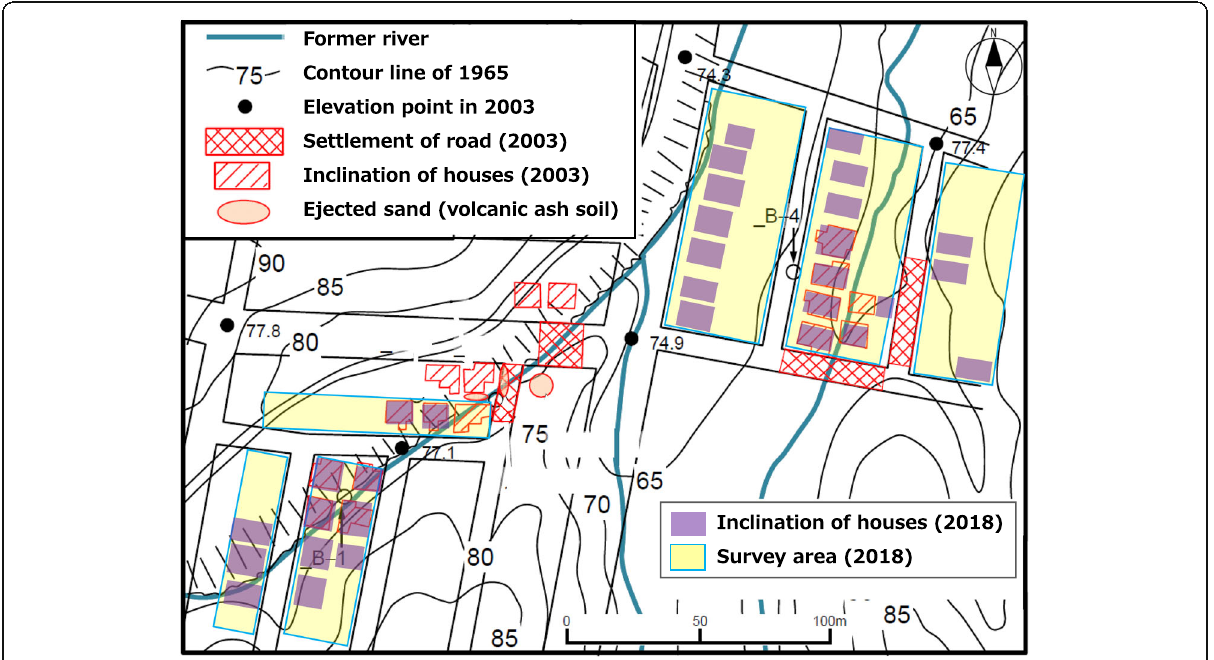
Fig. 7 Inclination of houses in the 2003 Tokachi-oki earthquake and the 2018 Hokkaido Iburi-tobu earthquake (The Japanese Geotechnical Society